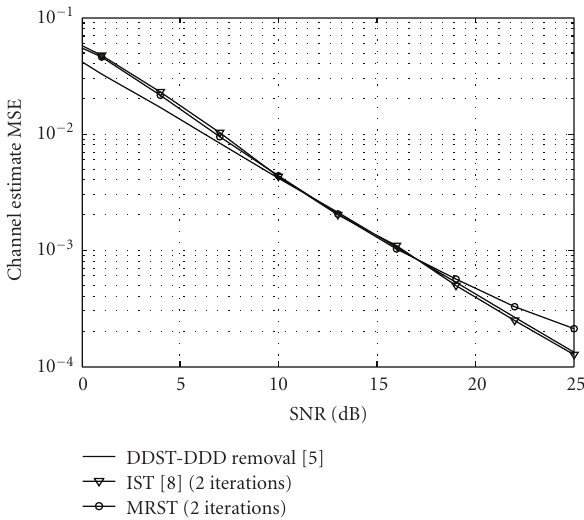
Figure 3: Channel estimate MSE with MMSE